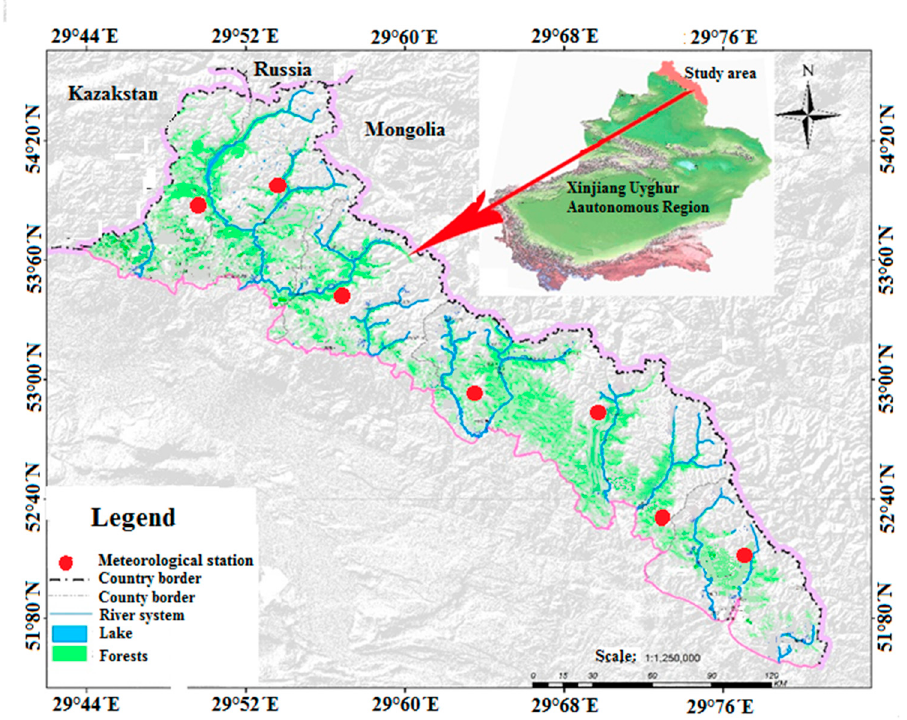
Figure 1. Location of Study Area (Driving number of map: GS (2019) 1823).